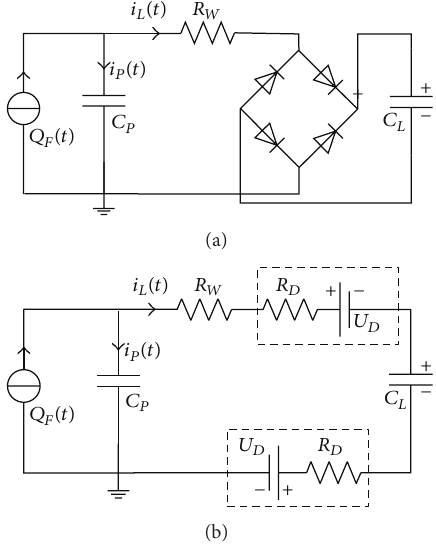
Figure 7: (a) The circuit for energy storage and (b) the equivalent circuit when bridge rectifier